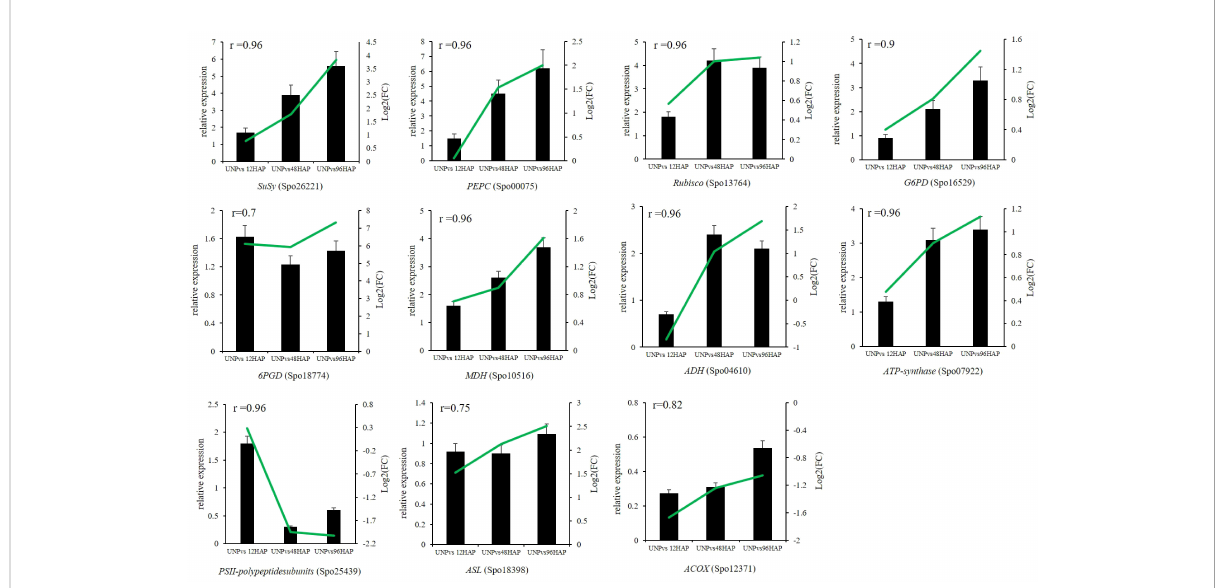
FIGURE 7 Relative expression of selected genes by qRT-PCR at different time points after pollination (12, 48, 96 HAP) in comparison with unpollinated fl ower sepals (UNP). Black bars show the relative expression (FPKM) in qPCR while green lines represent the log in RNA-seq. The correlations between qPCR and RNA-seq are shown with r